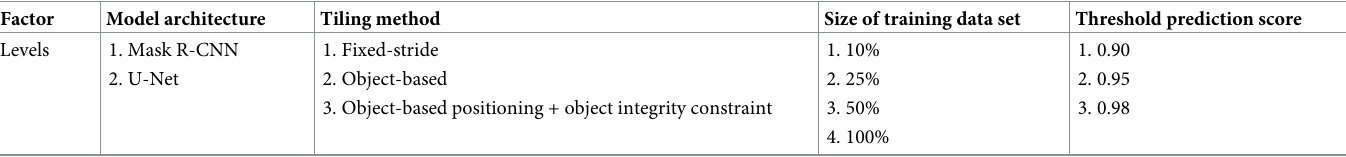
Table 2. Factors and levels of the full factorial experimental